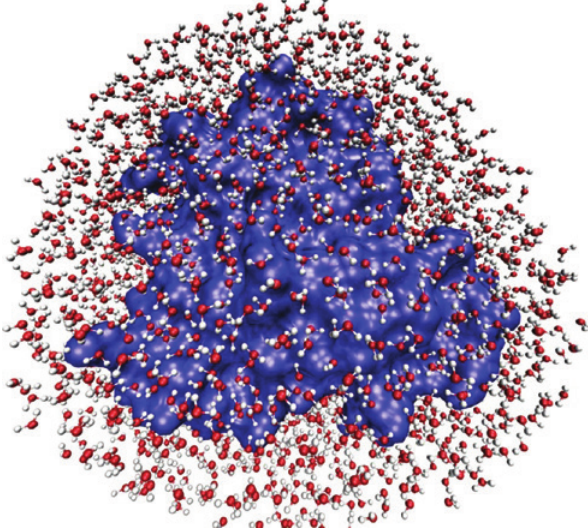
Figure 1: The hydration shell of myoglobin. CPK diagram (blue surface) with 1911 water molecules. The waters form a shell ≈5 Å thick around the protein. Approximately 200 water molecules are distinguishable from background with high-resolution X-ray crystallography. Reproduced from Frauenfelder et al.